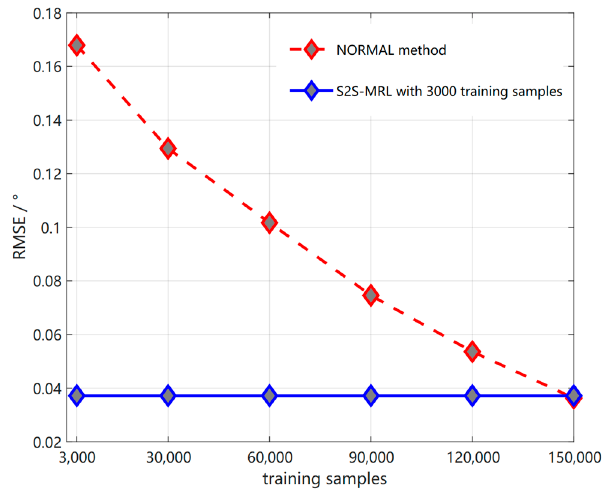
Figure 14. Comparison of RMSE between S2S-MRL and NORMAL method with different training samples and fixed small training samples, respectively.